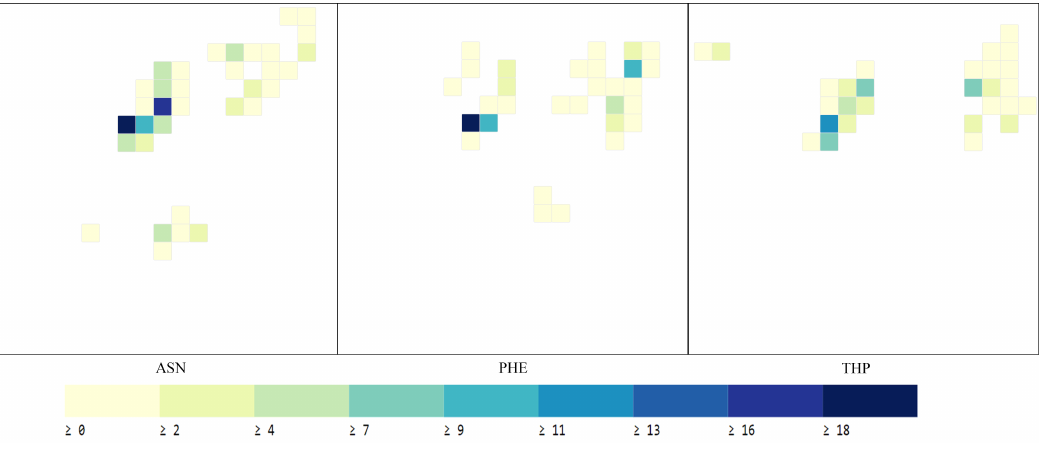
Figure 5. Torsion angles feature